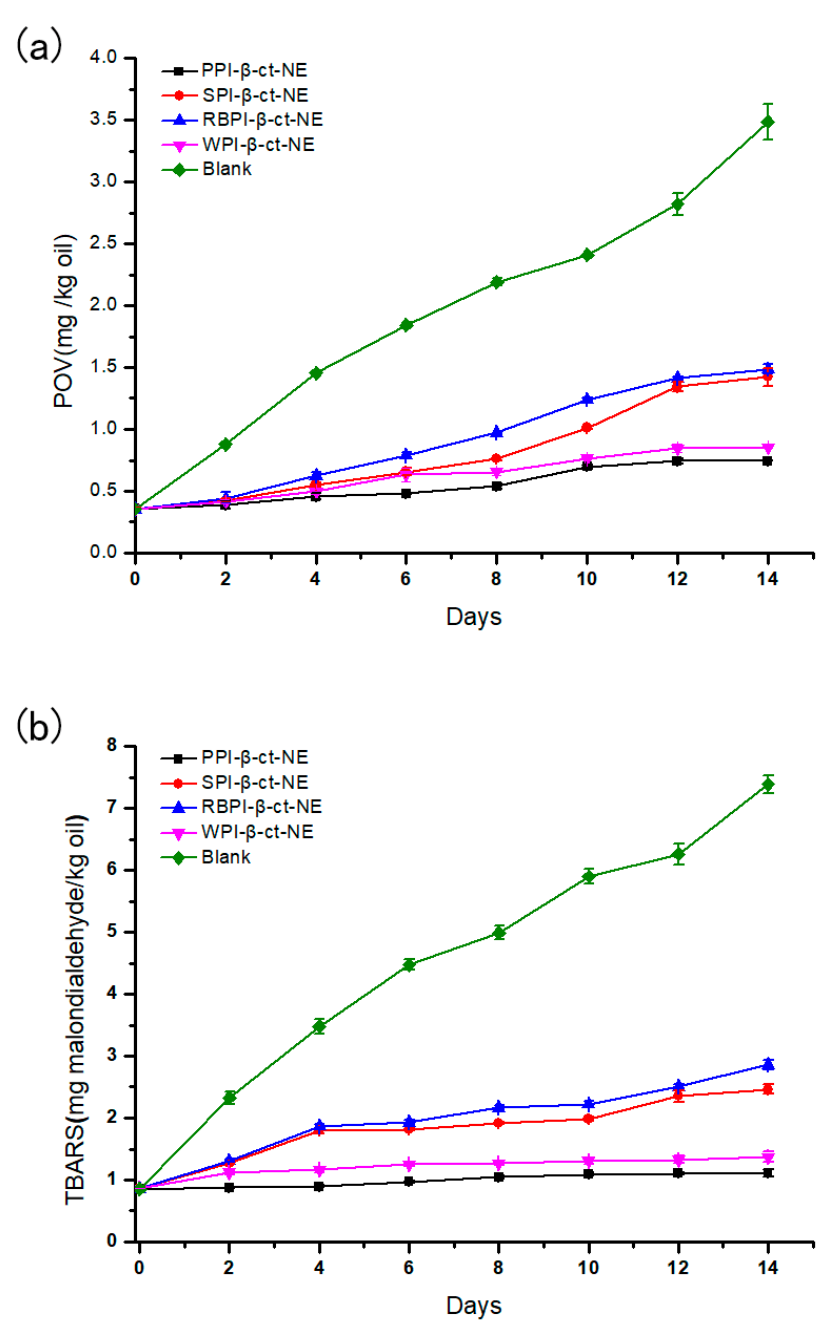
Figure 7. ( a ) Peroxide values (POVs) of PPI-, SPI-, RBPI-, and WPI-stabilized nanoemulsions over time; and ( b ) thiobarbituric acid reactive substances (TBARS) values of PPI-, SPI-, RBPI-, and WPI-stabilized nanoemulsions over time. The lines are for visual aid only and that the error bars are based on SD.